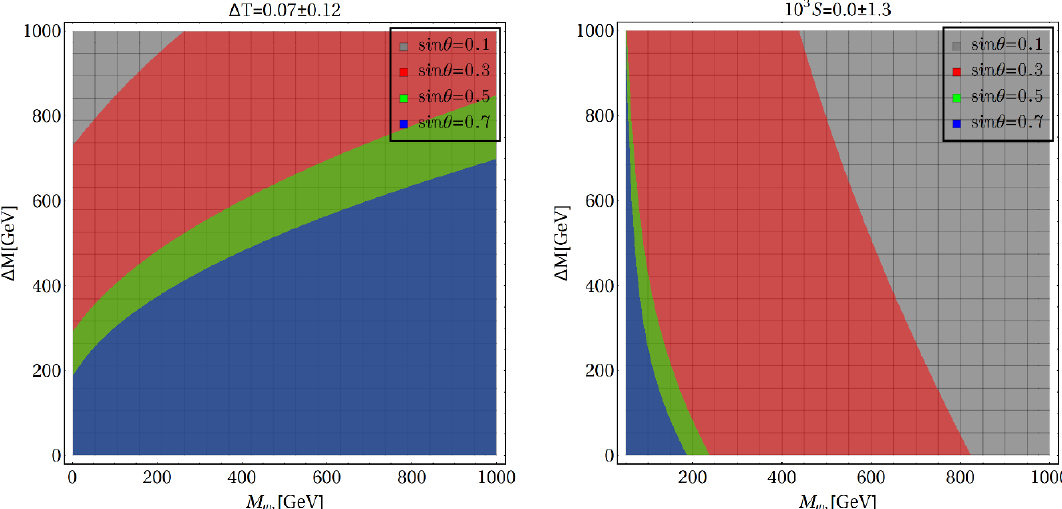
Figure 1 . Left: constraints on DM mass M and (cid:1) M from T parameter measurement for 1 sin (cid:18) : f 0 : 1 ; 0 : 3 ; 0 : 5 ; 0 : 7 g shown in red, green, blue and black respectively. Right: limit from ^ S on DM mass M and (cid:1) M for di(cid:11)erent choices of sin (cid:18) : f 0 : 1 ; 0 : 3 ; 0 : 5 ; 0 : 7 g shown respectively in 1 orange, green, blue and